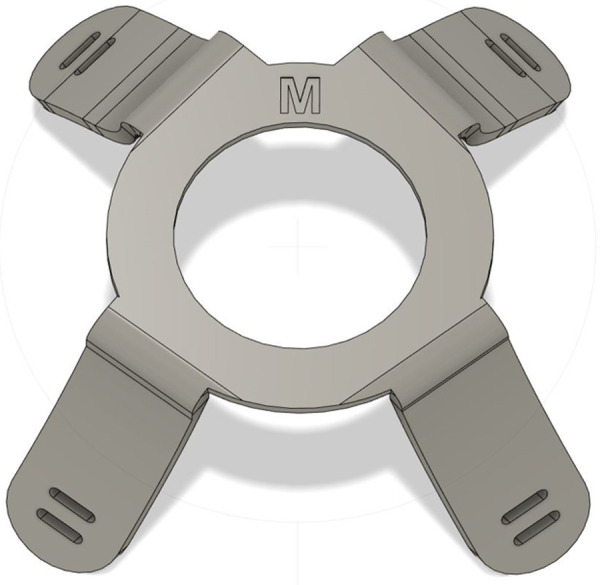
Design of the final model for the harness with holes for elastic strap attachment.